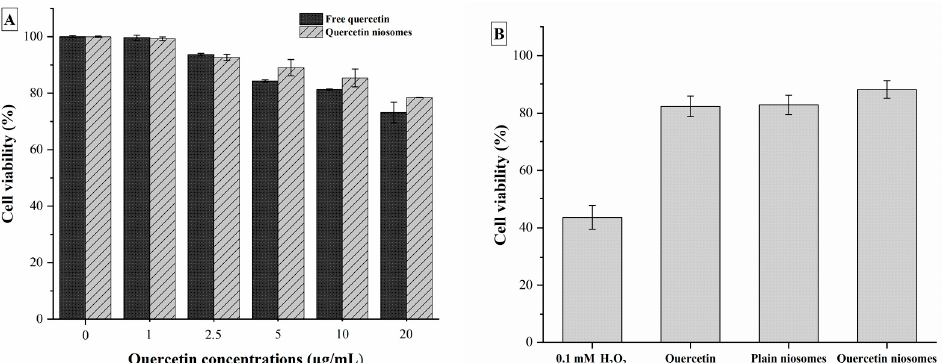
Figure 6. ( A ) Cell viability of HepG2 cells after exposure to quercetin and quercetin-loaded niosomes. ( B ) Protective e ff ect on H 2 O 2 -induced oxidative stress in HepG2 cells after exposure to quercetin, plain and quercetin-loaded niosomes.